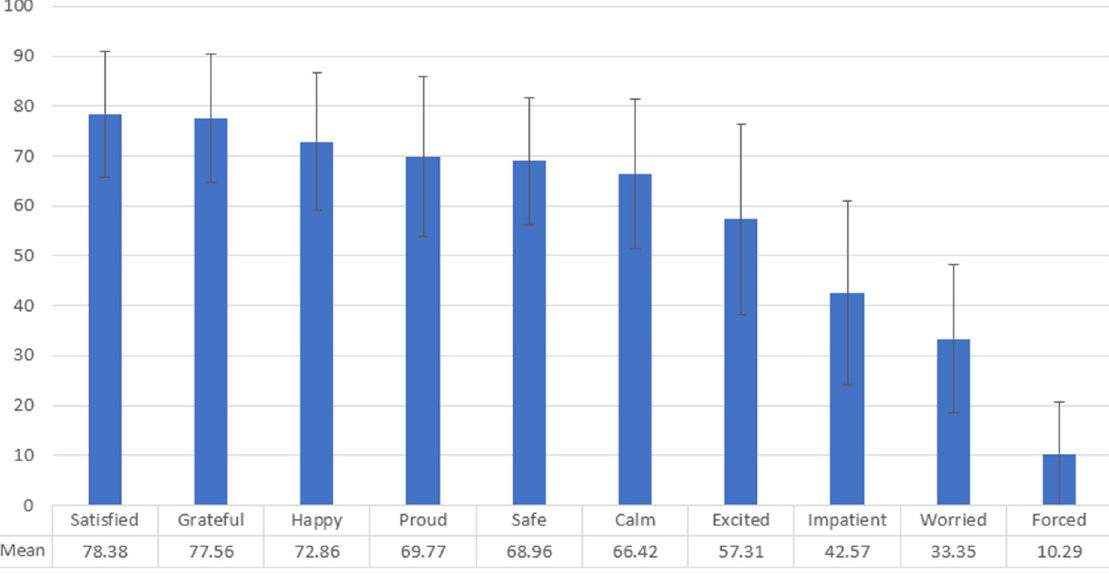
Figure 1. Emotional status (mean) at the moment of vaccination reported by participants ( n = 159). Bars show standard deviation.